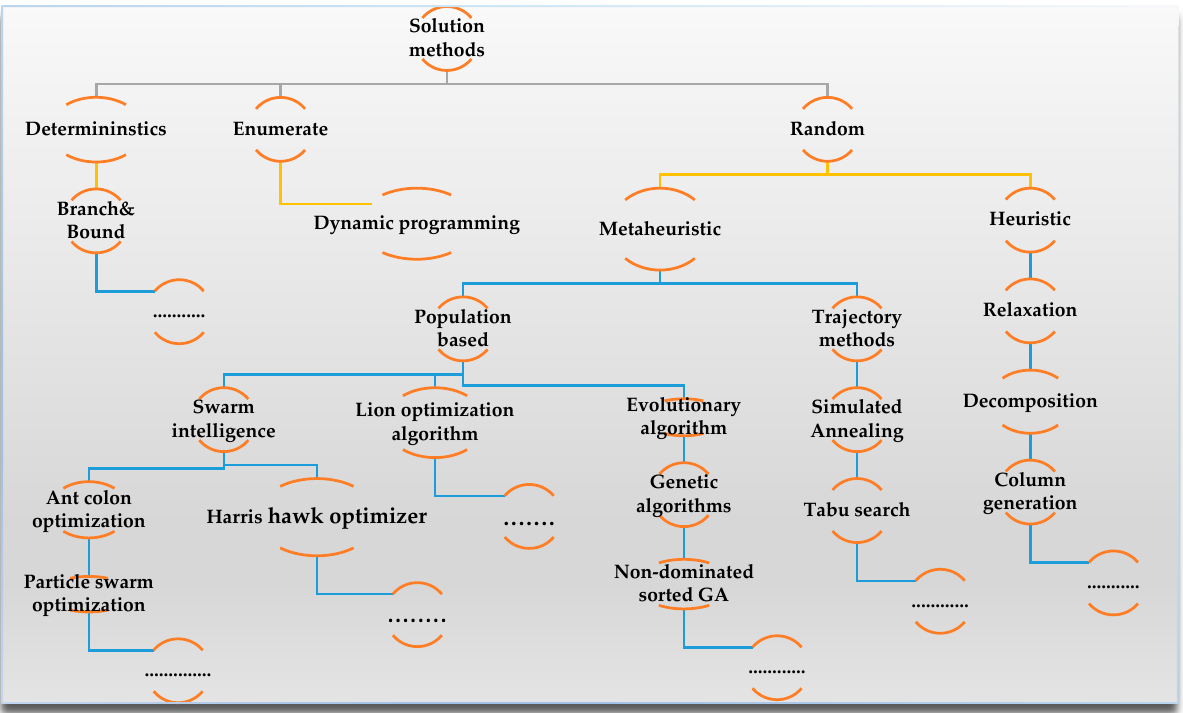
Figure 3. Organizations of different single-objective solution methods for OR scheduling problems [17].